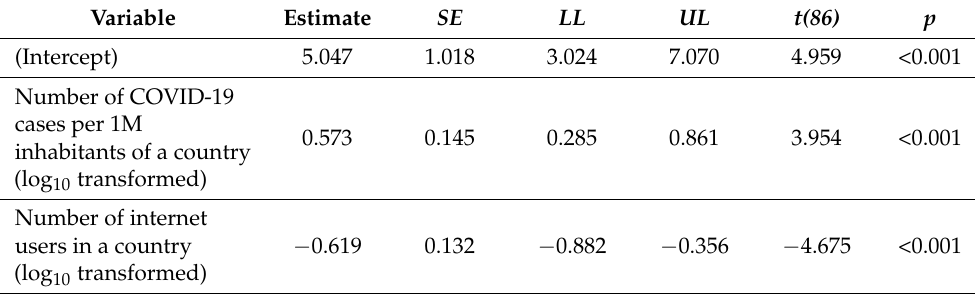
Table 2. Results of the linear model testing the association between the relative interest in coronavirus memes (Google Trends index) and total number of COVID-19 cases per one million inhabitants and percentage of internet users in different countries. Estimates of functions slopes are given with standard errors (SE), 95% confidence intervals (LL–lower confidence intervals, UL–upper confidence intervals) and t –test (with residual degree of freedom). Model explained 27% variation in data (adjusted R 2 ).